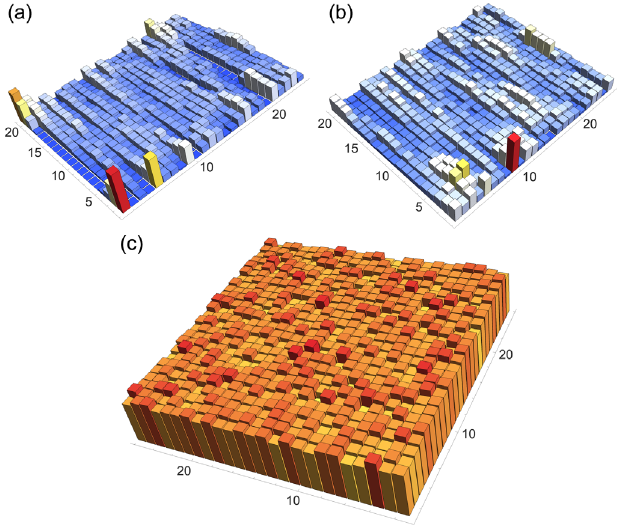
FIG. 6. Uniformity check of generated random unitaries. We consider the time evolution of a driven L ¼ 5 chain with random fields [Eq. (2)], where K ¼ 100 , g ½ − 0 . 5 ; 0 . 5 (cid:2) , while ϕ k and ω k are sampled in ½ − L; L (cid:2) . The statistics is done with 10 4 independent realizations. The discrete histro- gram is computed according to the decomposition [69] as FIG. 5. Convergence of the singular value s ð t Þ of e t L e t L † to described in the main text. (a) Noncontrollable case where noise (cid:3) e − λ (cid:3) t , where λ is the Liouvillian gap. The relative error Δ ð t Þ is applied on the central site for a time t ¼ 25 . (b) Controllable (cid:3) and − t − 1 log s ð t Þ is plotted for the different values of between λ case where the noise is applied on the first site for a short time (cid:3) σ ; the time axis is rescaled between 0 and 2 λ − 1 t ¼ 5 . (c) Controllable case where the noise is applied on the first . In the (cid:3) site for a long time t ¼ 55 simulations, L ¼ 10 , q ¼ 1 .